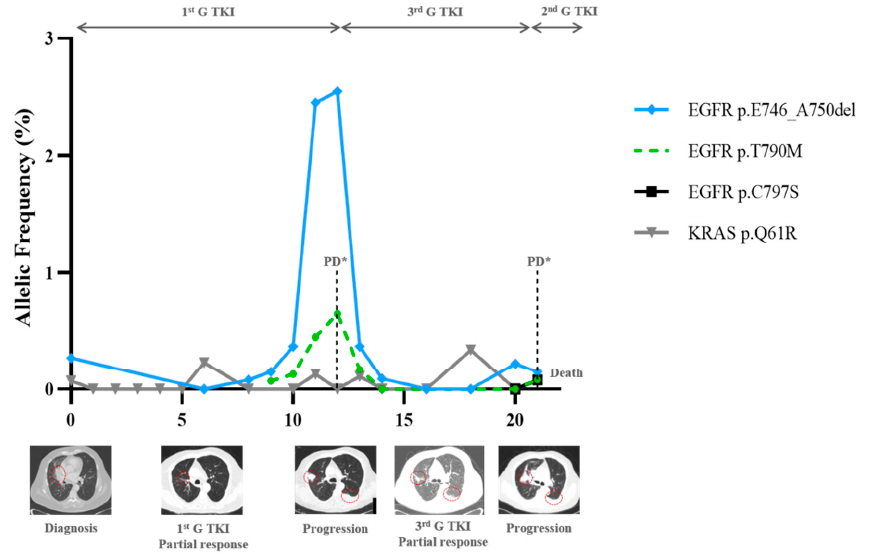
Figure 5. Complete ctDNA monitoring of a patient with Del19 EGFR mutation and representative CT scans at indicated time points. With both 1st and 3rd G TKIs, clinical response was accompanied by molecular decrease in the driver mutation. Clinical progression was preceded by an increase in del19 and the appearance of the T790M. After the initiation of the 3rd G TKI, partial response was observed with ctDNA clearance of both clones. At the recurrence time, the patient lost the T790M, del19 reappeared, and the C767S in cis was detected. Plasmatic alterations at progression were both confirmed with a tissue biopsy represented by *. Red circles refer to main tumour lesions.